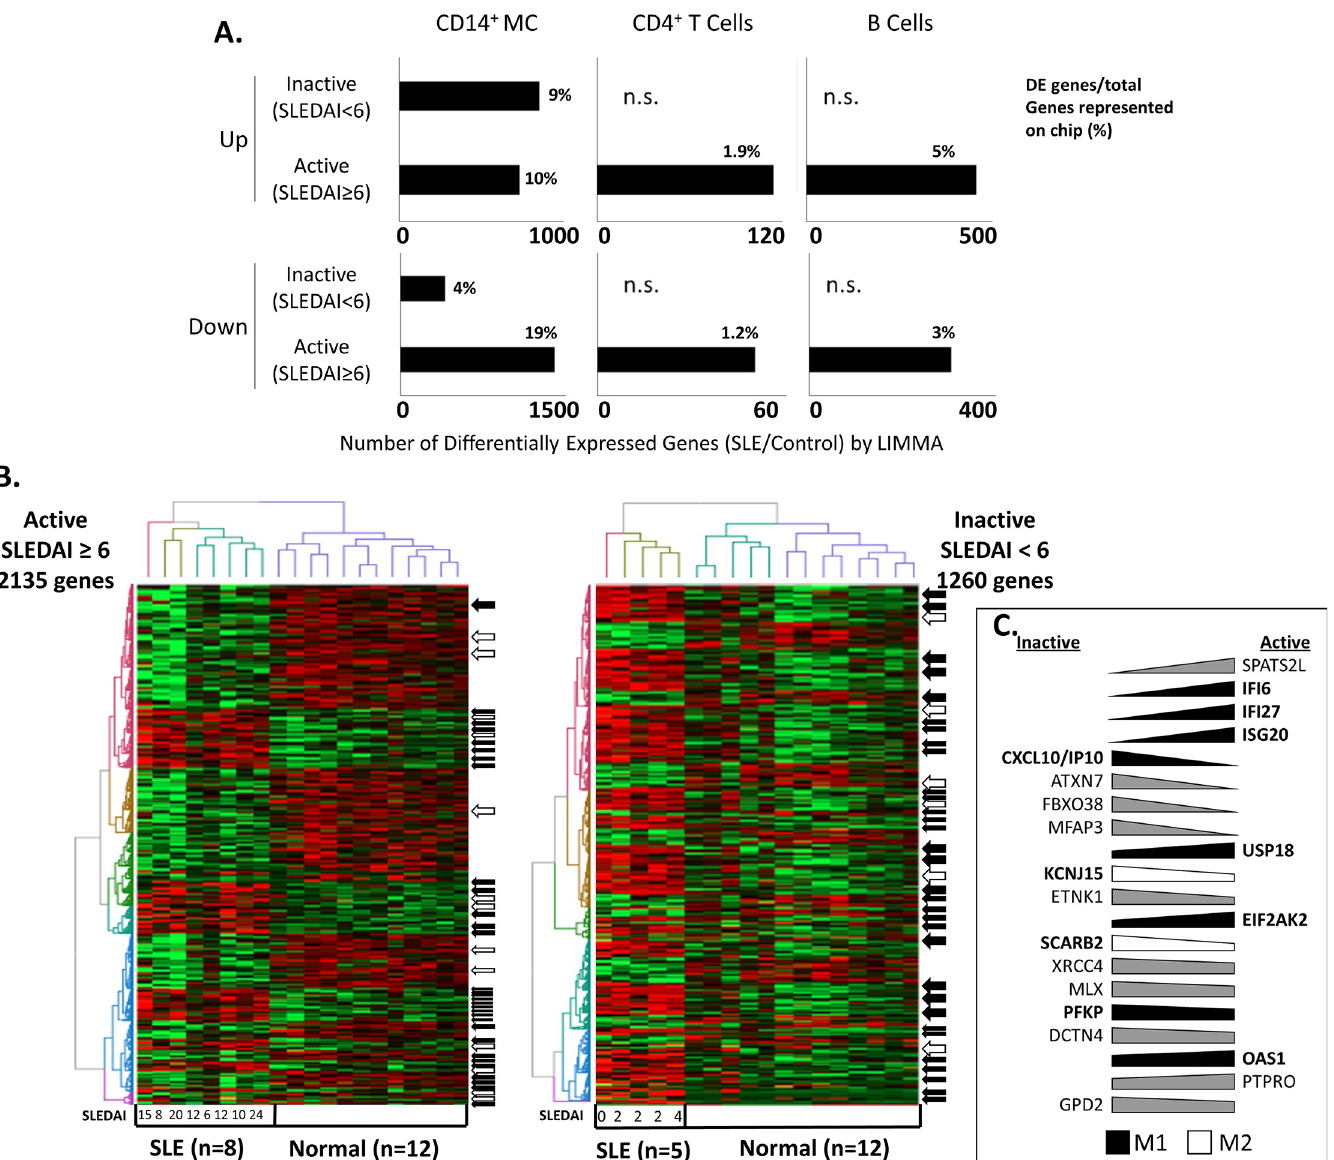
Fig 1. Differential expression of CD14 + monocyte genes in active and inactive SLE. (A) Number of differentially expressed (DE) genes detected by LIMMA analysis in MC, CD4 + T cells, and B cells isolated from inactive (SLEDAI < 6) and active (SLEDAI � 6) SLE patients when compared to healthy donors. n.s.: no genes found to be significantly differentially expressed (FDR < 0.2) when compared to healthy controls. (B) Hierarchical clustering of differentially expressed (DE) genes detected by LIMMA analysis in CD14 + MC isolated from inactive (SLEDAI < 6) and active (SLEDAI � 6) SLE patients when compared to healthy donors. Arrows highlight M1 (black) or M2 (white) polarization genes as reported by Martinez et al.[52] (C) Fold change variation of genes found to be upregulated in both active and inactive SLE MC. Polarization-related genes are shown in bold and M1 genes are represented by a black wedge while M2 genes are represented with a white wedge. Genes not associated with M1 or M2 pathways are represented with a gray